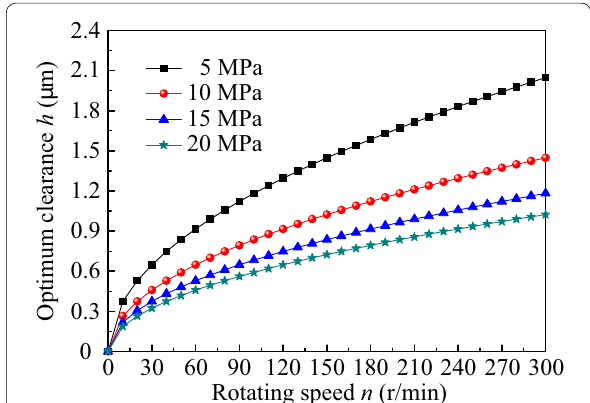
Figure 8 Change of optimal clearance with rotating speed at various pressures